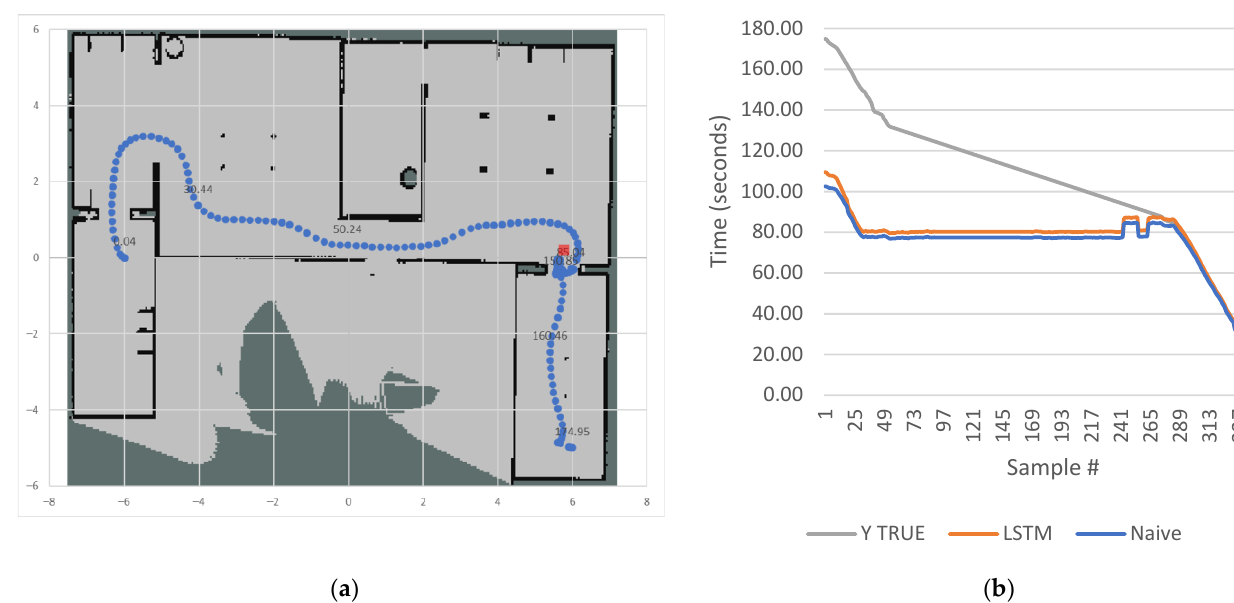
Figure 14. The path is blocked. ( a ) Trajectory on map. Red square marks the position of the obstacle. ( b ) Time samples and estimates of travel time.